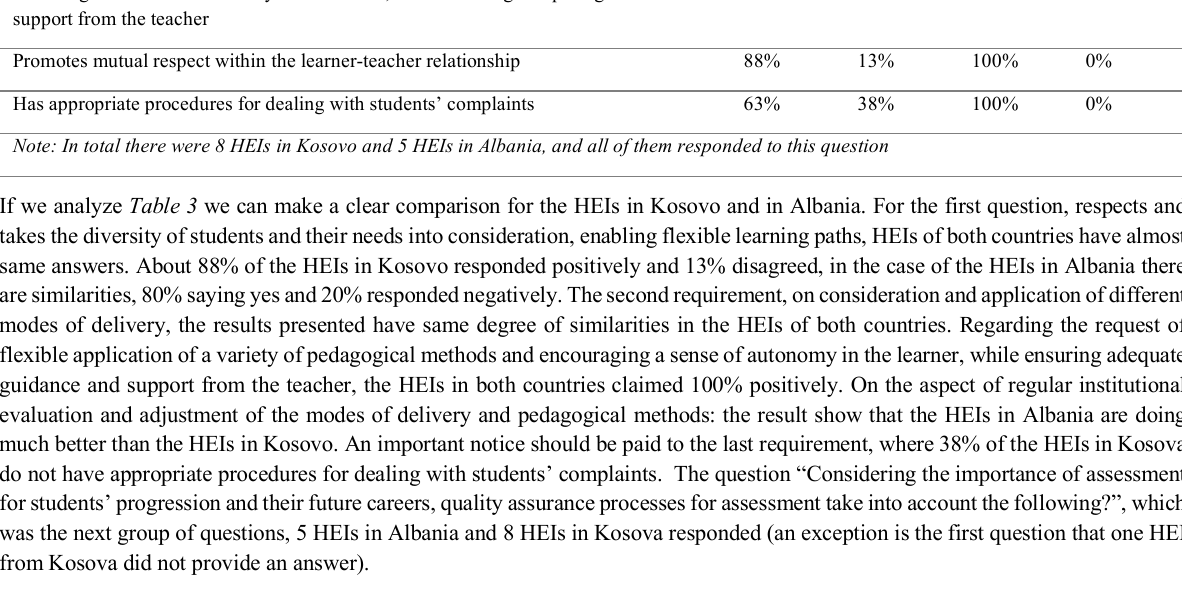
Table 4: Fifth question on Internal Quality Assurance: Student admission, progression, recognition and